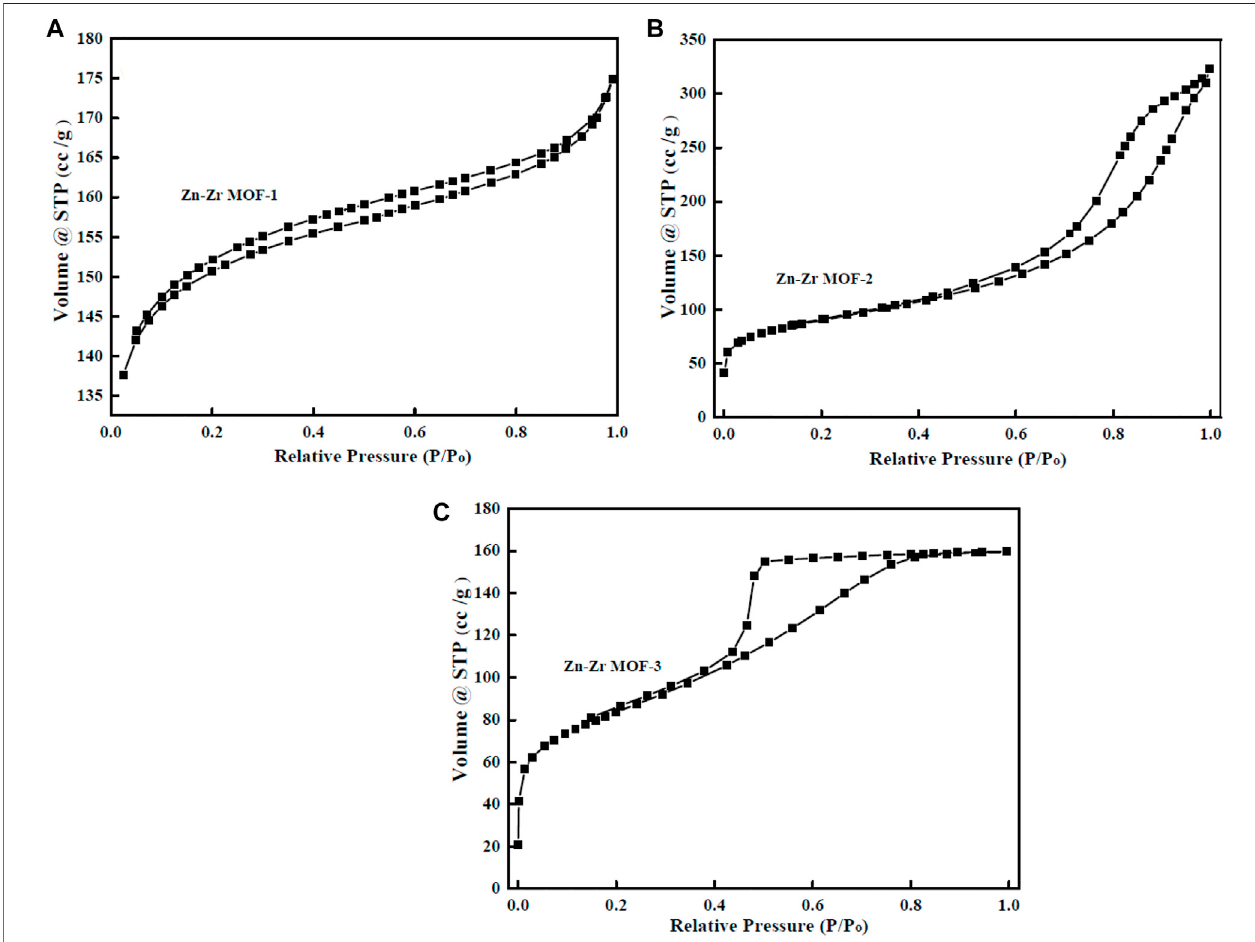
TABLE 1 | BET surface areas and total pore volumes of the synthesized samples. Figure 5B and Table 2 . The results of kinetic studies on the degradation of RhB over the different photocatalysts showed